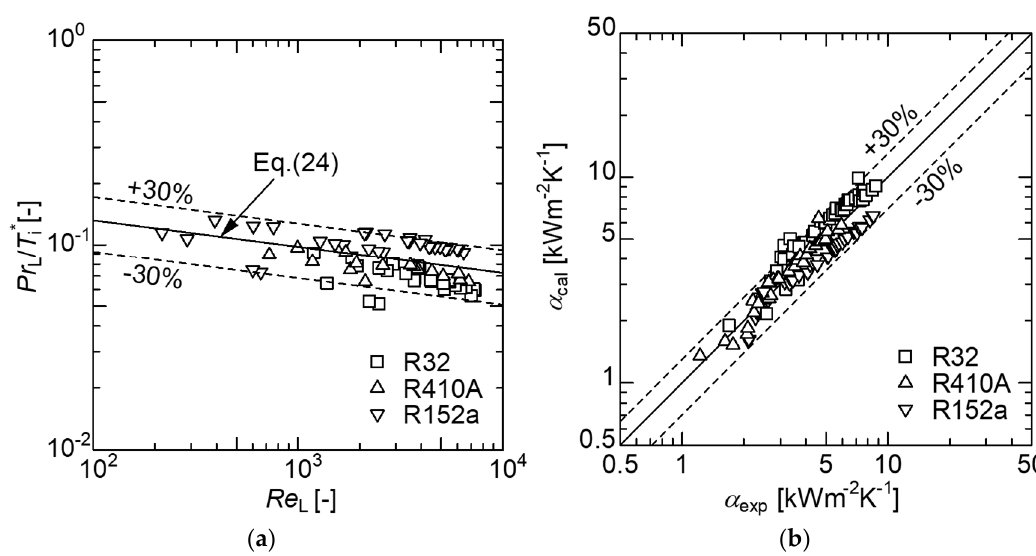
Figure 7. ( a ) Relationship between relative temperature difference and liquid Reynolds number in R32, 410A. ( b ) Heat transfer coefficient correlation between that predicted by the present correlation, and the measured values of R32, R410A, and R152a.